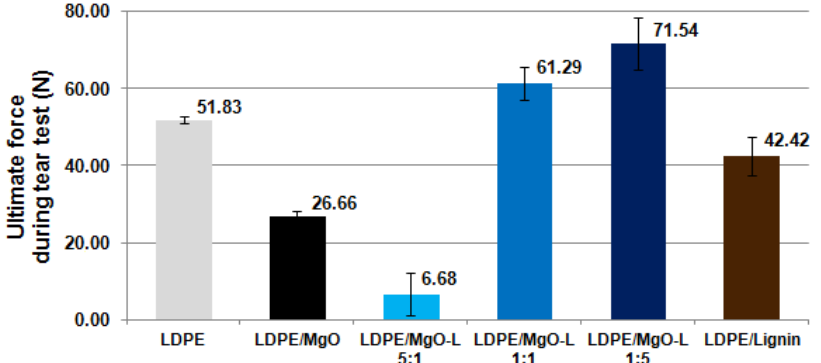
Figure 8. Comparison of the ultimate shear force applied in lap shear test.